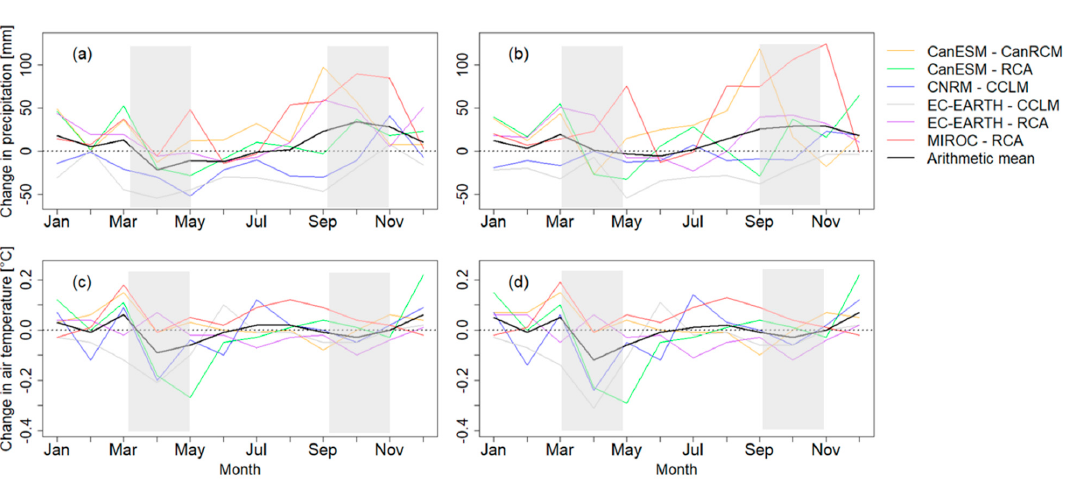
Figure 7. Projected changes in mean monthly precipitation and air temperature for the future period 2021-2050 in comparison with 1976-2005. ( a ) and ( c ) indicate RCP4.5, and ( b ) and ( d ) represent RCP8.5. Shaded areas represent wet season, while unshaded areas represent dry season. Data used is bias- corrected.